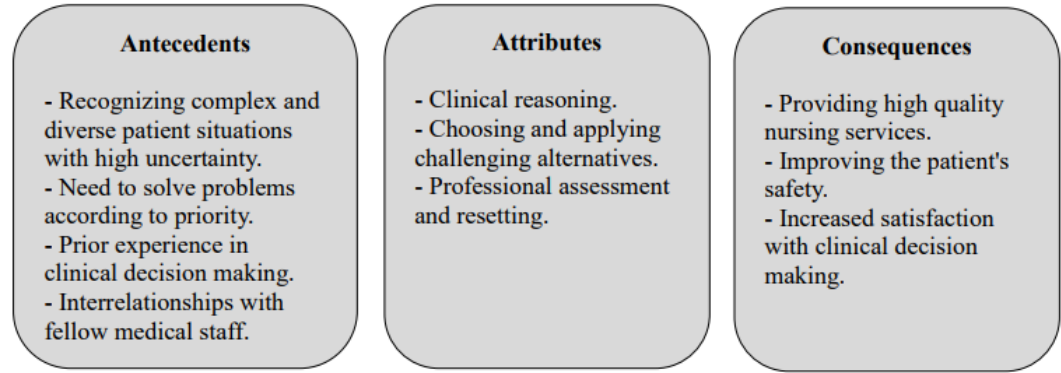
Figure 2. conceptual diagram of clinical decision